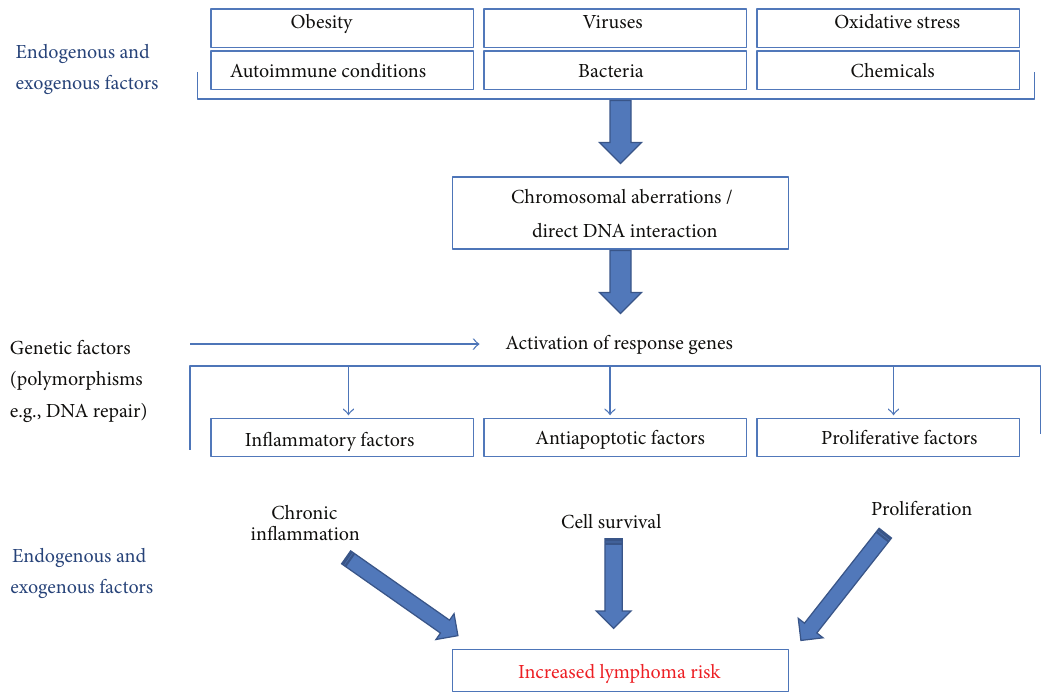
Figure 5: Schematic of general pathways leading to increased risk of developing lymphoma.